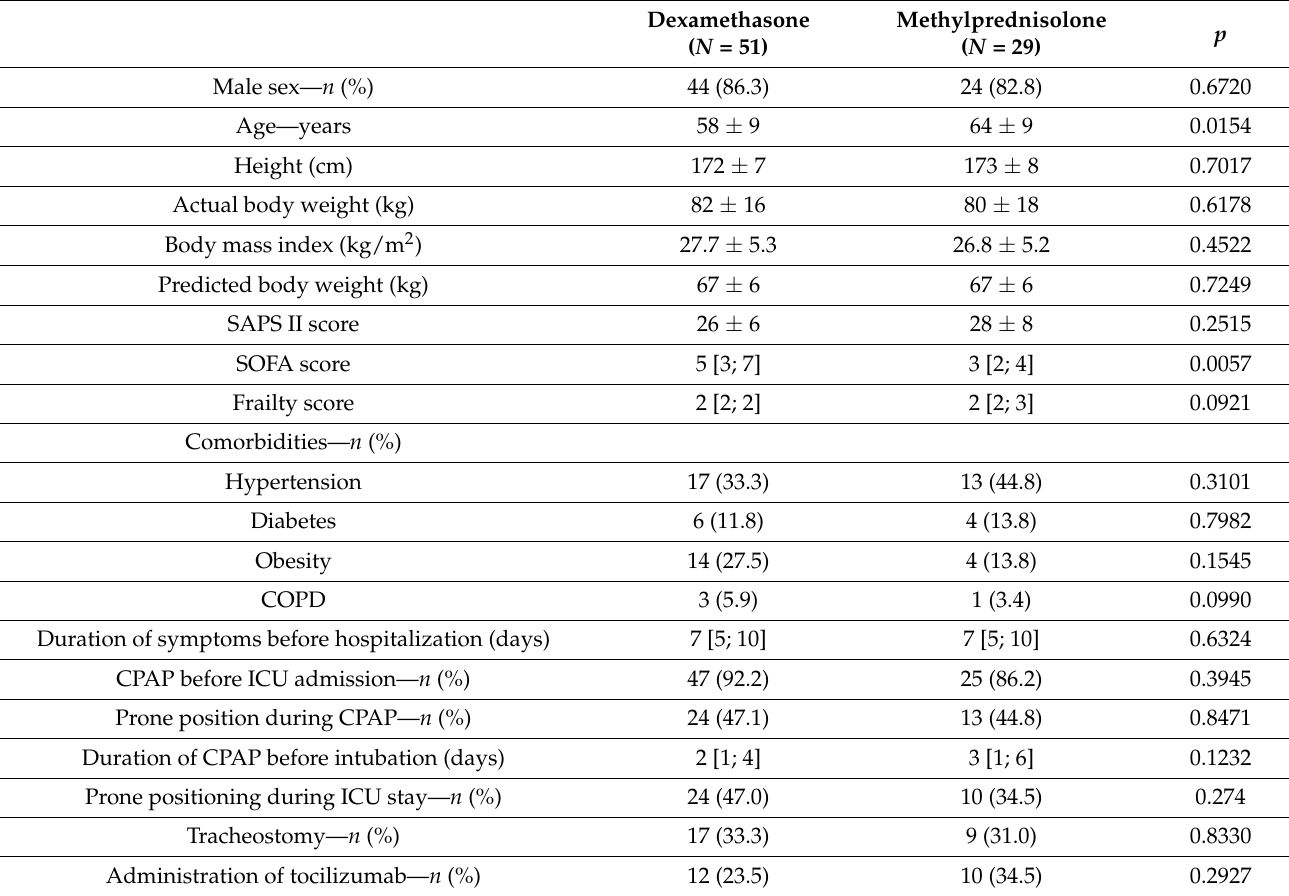
Table 1. Comparison of baseline characteristics of patients who received dexamethasone vs.